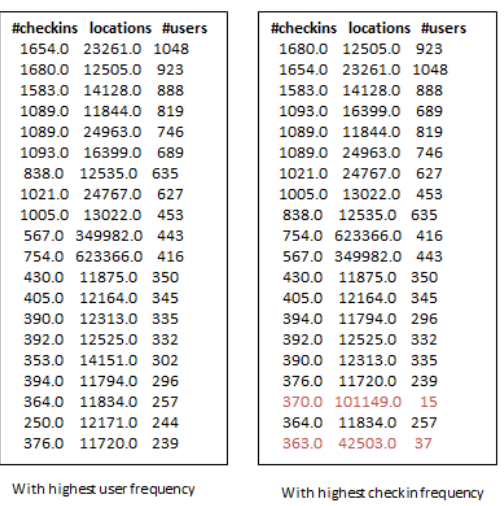
Figure 6. Top-20 influential locations selected by IR and RF algorithms across New York.